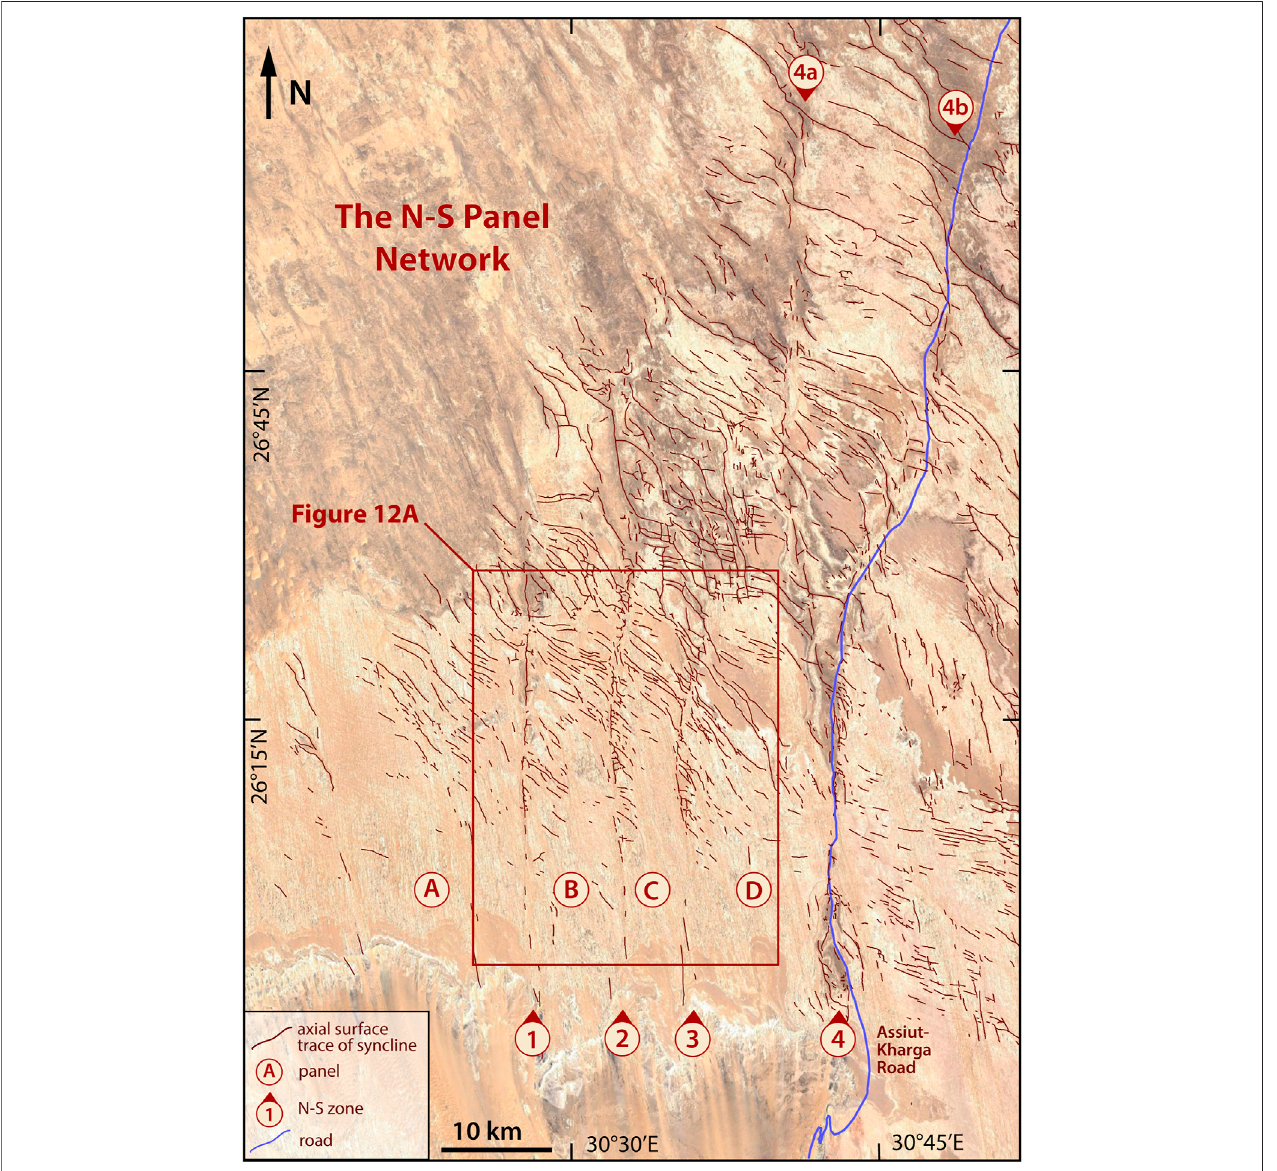
FIGURE 10 | Synclines in the N – S panel network. Four panels (A – D) are 5 – 10 km wide and have WNW – ESE to NW – SE trending synclines. Four N – S zones (1 – 4) are narrow and have synclines with both N – S trends and NNW-SSE trends. Synclines in the panels curve to become more northerly with proximity to the N – S zones, de fi ning an overall Lazy-S pattern in each